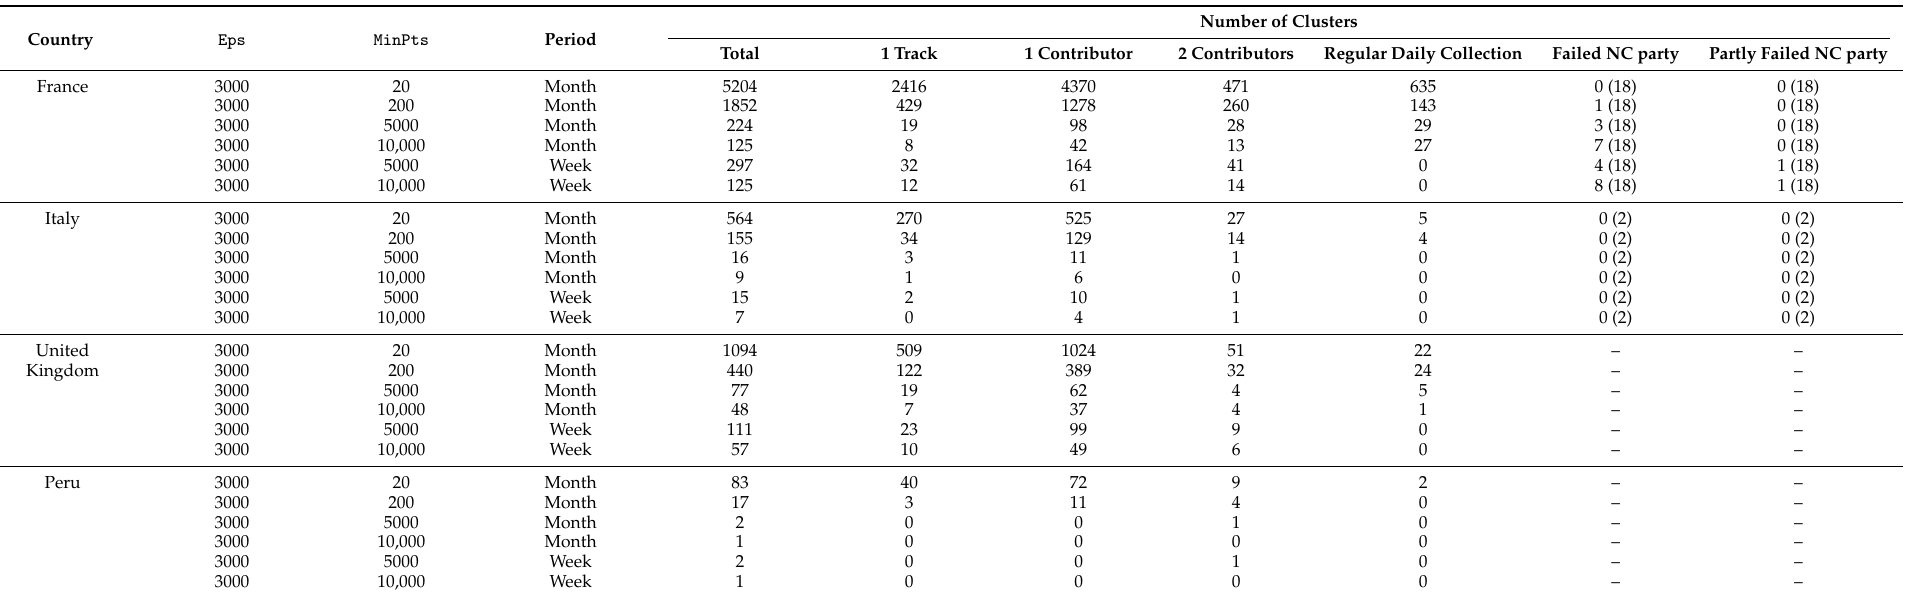
Table 4. Number of clusters found by the DBSCAN approach in function of the MinPts parameters by filtering the data by month or by week. The number of clusters with one track or one or two contributors is also given, as well as the clusters with a regular daily collection (i.e., between 2 and 5 tracks per day). The number in parenthesis is the number of NC party events in the country. “Failed NC party” means that all the points of the event were not clustered, while “Partly failed NC” means that at least 70% of the event was clustered. When “Failed NC party” and “Partly failed NC” are both equal to zero, the NC parties are fully